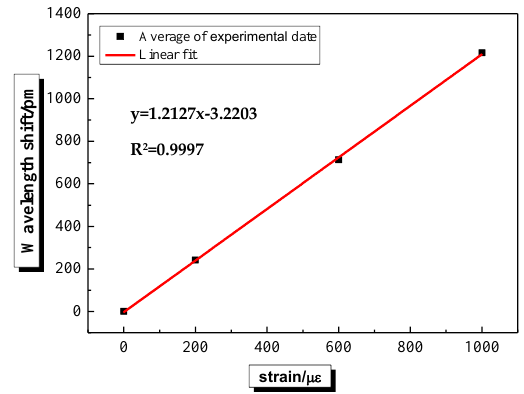
Figure 2. The curve of strain calibration.